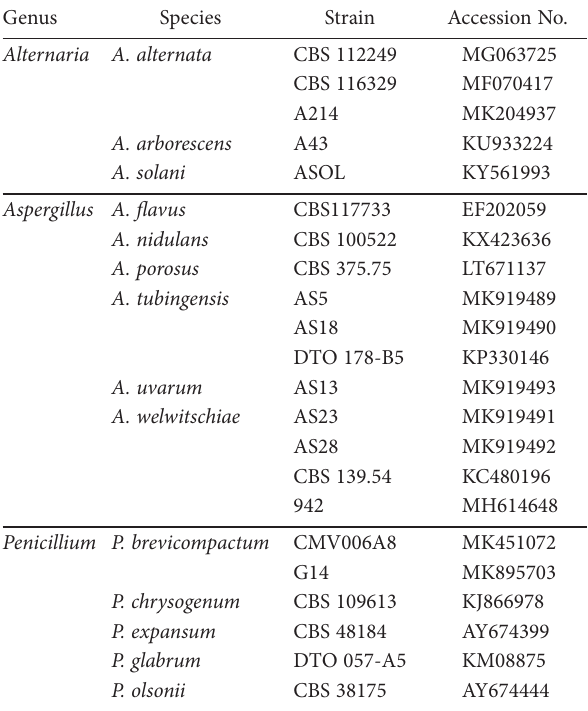
Table 2. Reference strains used in phylogenetic analyses and their GenBank accession